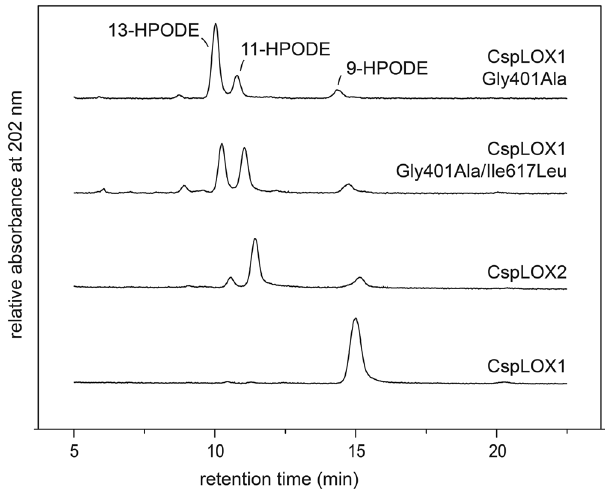
Figure 4. Two amino acid substitutions in CspLOX1 induce 11-HPODE production. Chromatogram of the HPLC analyses of products formed by the Gly401Ala and the Gly401Ala/Ile617Leu variant of CspLOX1 as well as the wt of CspLOX2 and CspLOX1. While CspLOX1 only produces 9-HPODE, the Gly401Ala variant and the Gly401Ala/Ile617Leu variant produce significant amounts of the bis-allylic 11-HPODE that is characteristic for